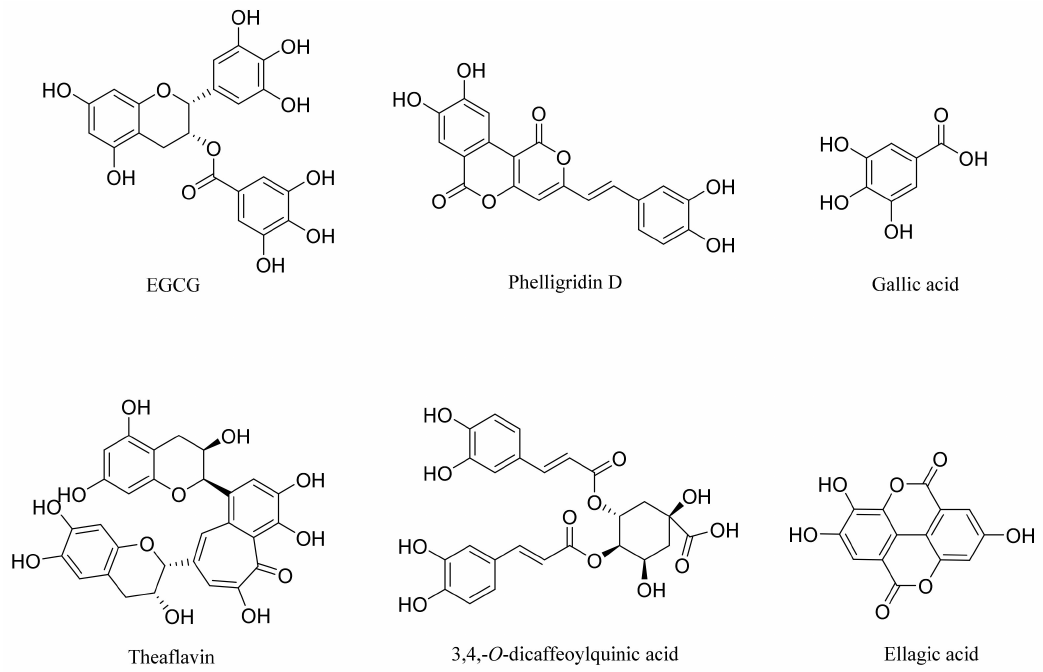
Figure 1. Representative chemical structures of phenols or polyphenols with antiviral